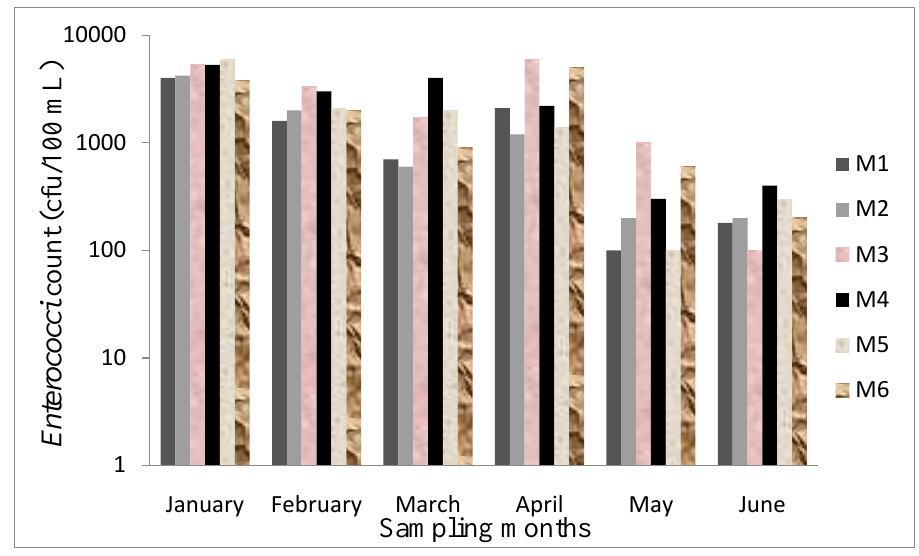
Figure 3. Enterococci count in each sampling site of Mvudi